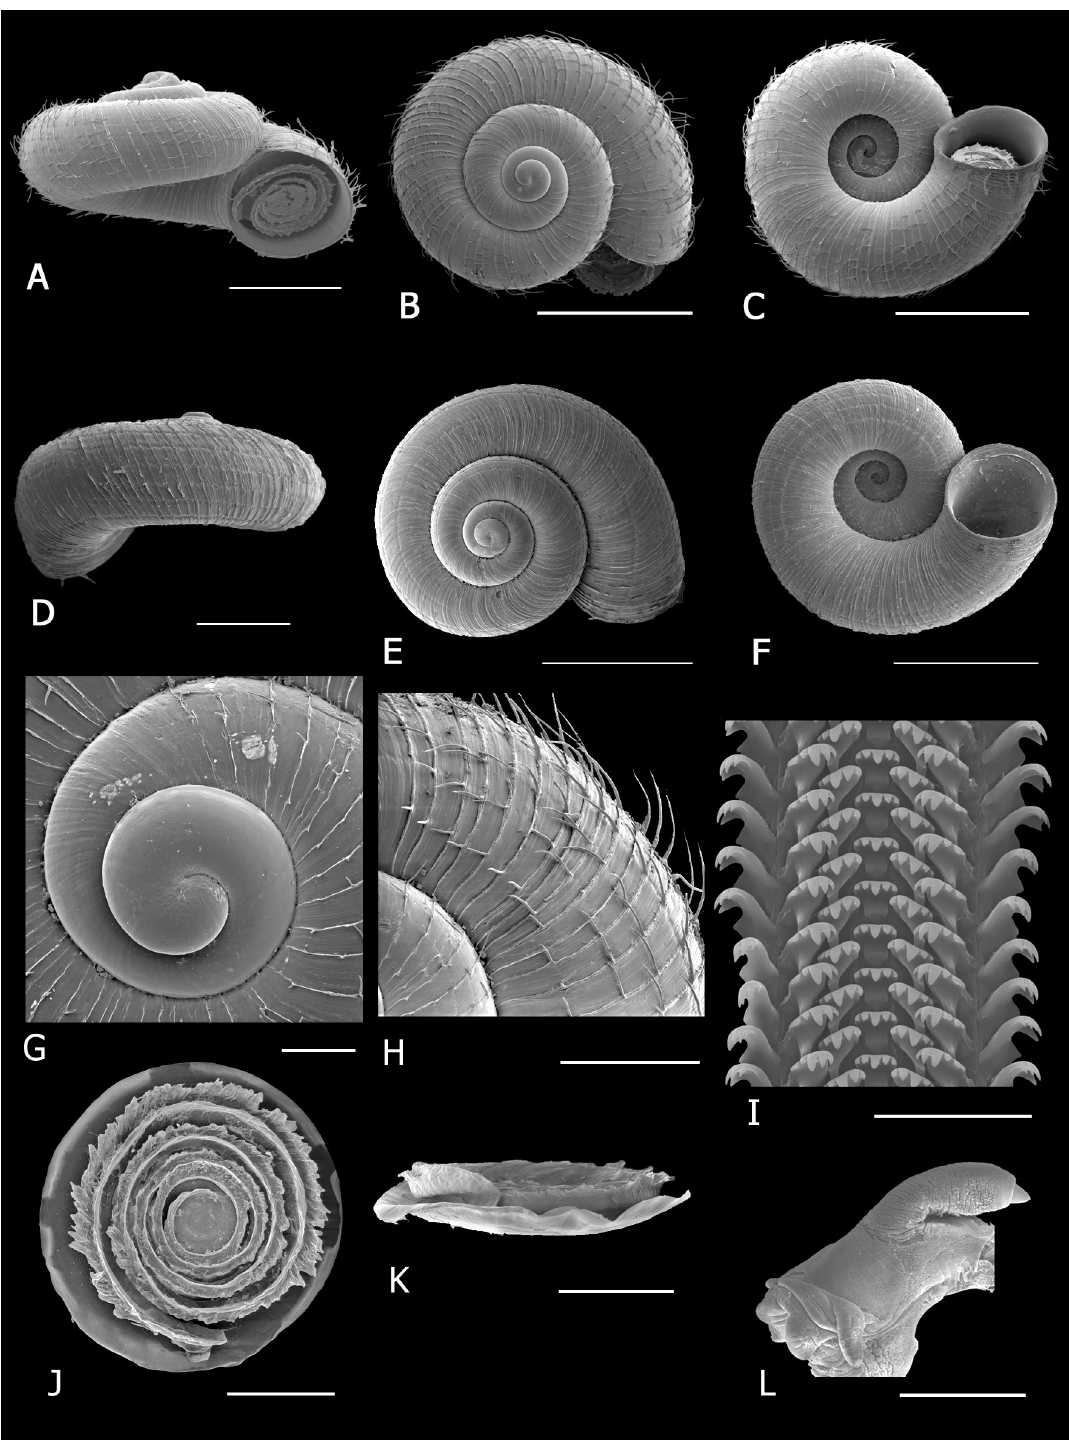
Fig. 26. Chondrocyclus kevincolei sp. nov. A . Aperture view (ELM W3615/T82). B . Dorsal view (ELM W3615/T82). C . Ventral view (ELM W3615/T82). D–F . Shell views, showing spiral grooves (NMSA W5659/T4122). G . Protoconch (ELM W3615/T82). H . Detail of axial lamellae of periostracum (ELM W3615/T82). F . Portion of radula (ELM W3615/T82). J–K . Operculum (ELM W3615/T82). L . Penis, lateral view (ELM W3615/T82). Scale bars: A–F = 2 mm; G = 200 µm; H, J–K = 500 µm; I = 50 µm; L = 1